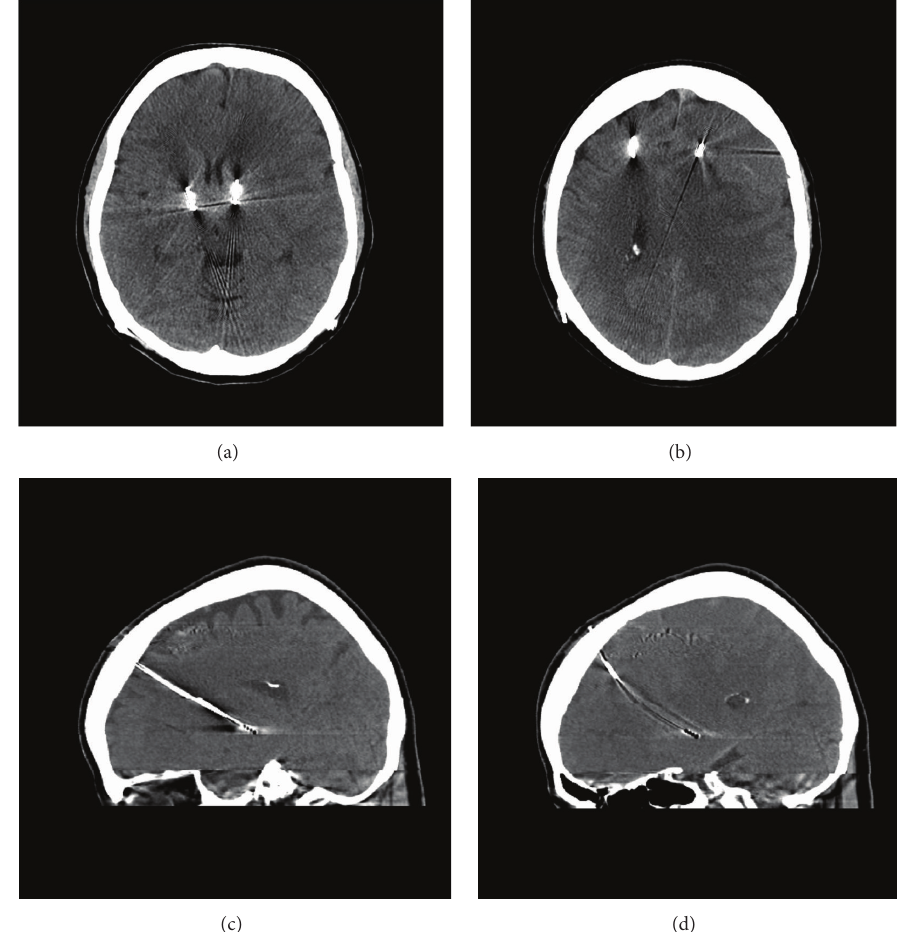
Figure 1: (a) CT head demonstrates left to right brain shift. (b) CT head demonstrates isodense pathology along left convexity. (c) CT head sagittal view demonstrates R DBS lead with relative normal position. (d) CT head sagittal view demonstrates L DBS lead that has bowed compared to the R DBS